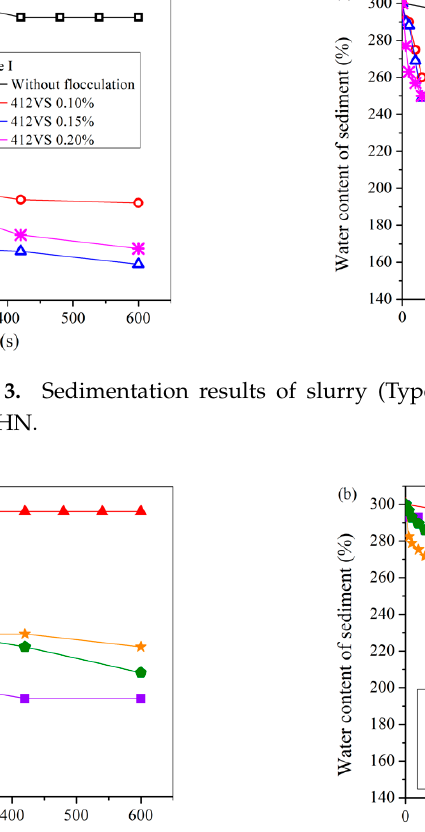
Figure 4. Sedimentation results of slurry (Type Ⅱ ) after pretreatment with CPAM. ( a ) 412VS. ( b ) 611HN.